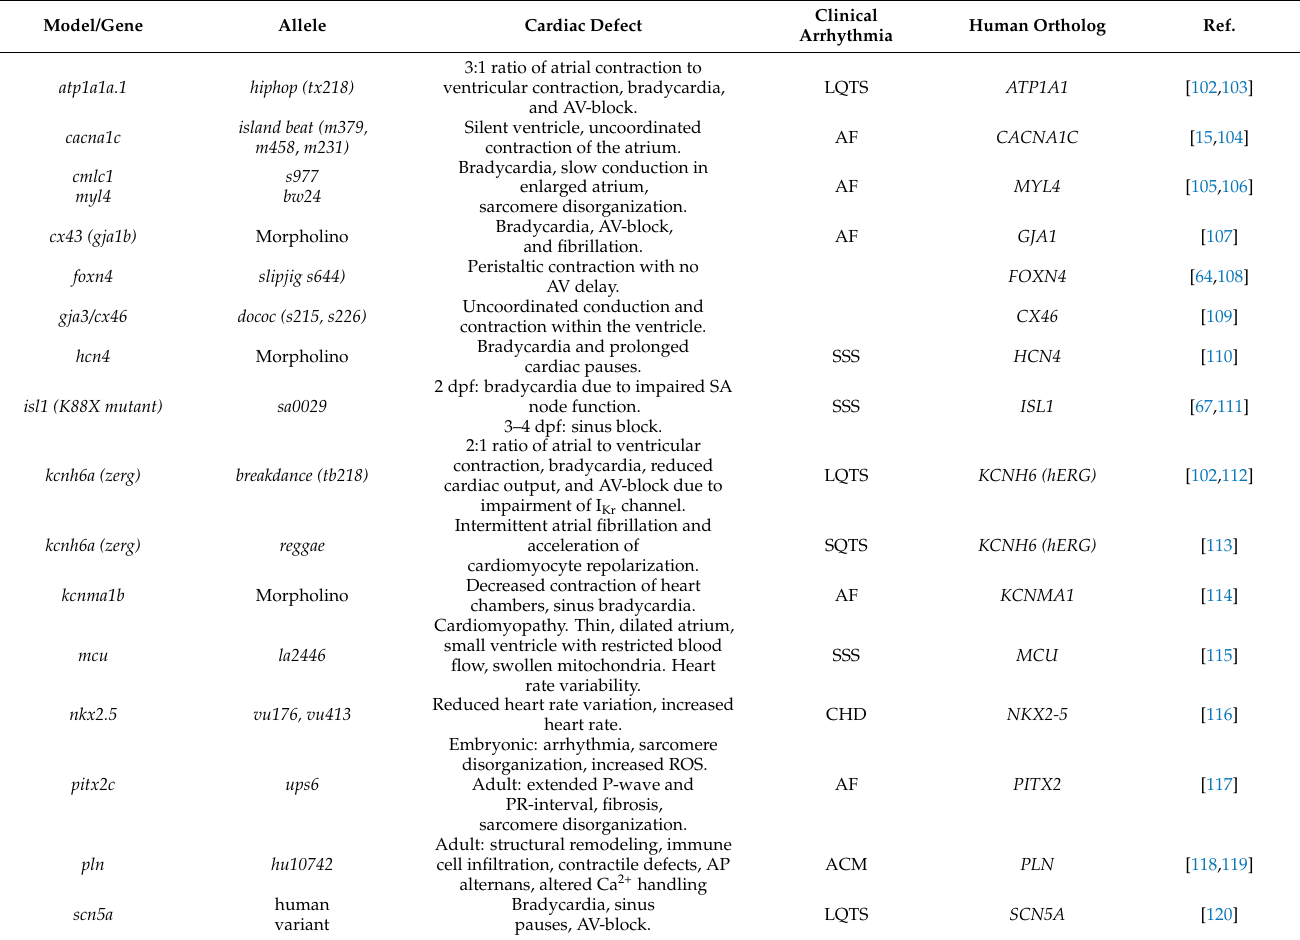
Table 1. Zebrafish models of cardiac